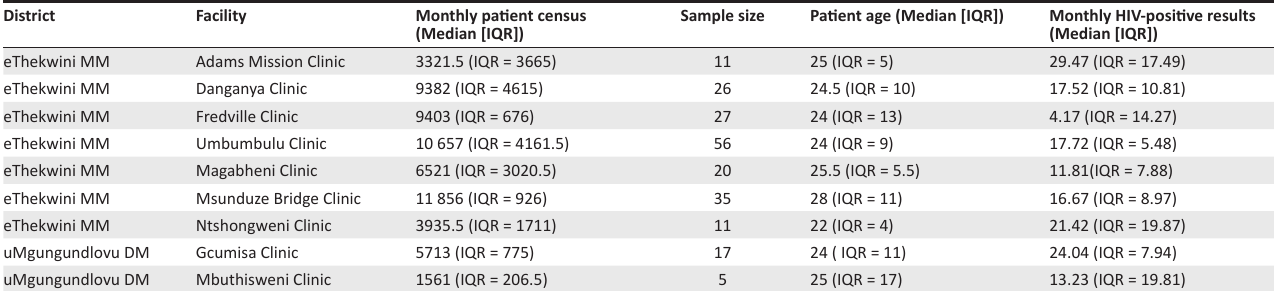
TABLE 1: Characteristics of the participating patients.